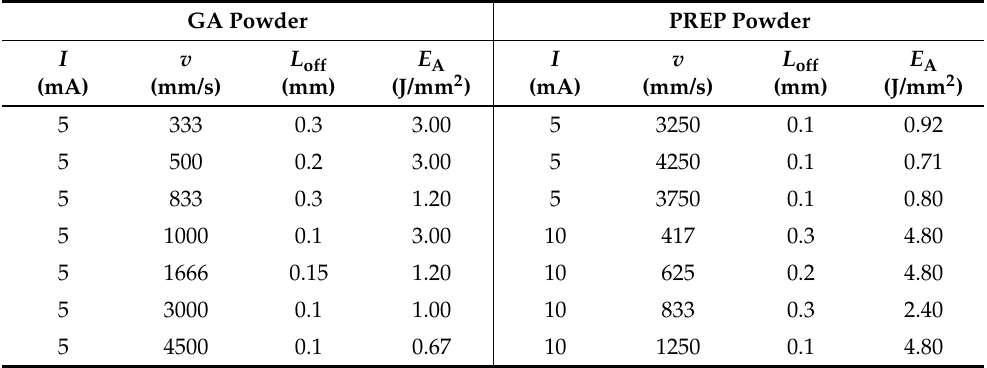
Table 4. Summary of the processing parameters of two types of GH4099